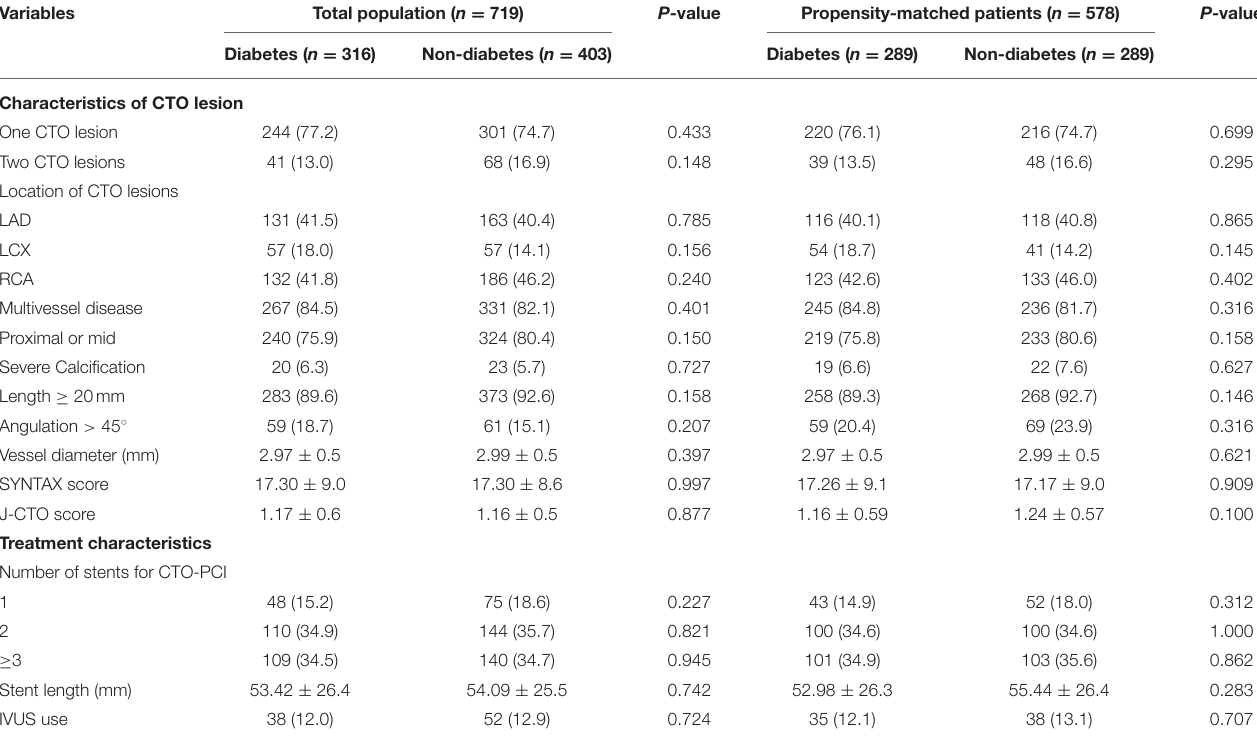
TABLE 2 | Lesion and treatment characteristics in the diabetes and the non-diabetes groups. Variables Total population ( n = 719) P -value Propensity-matched patients ( n = 578) P -value Diabetes ( n = 316) Non-diabetes ( n = 403) Diabetes ( n = 289) Non-diabetes ( n =